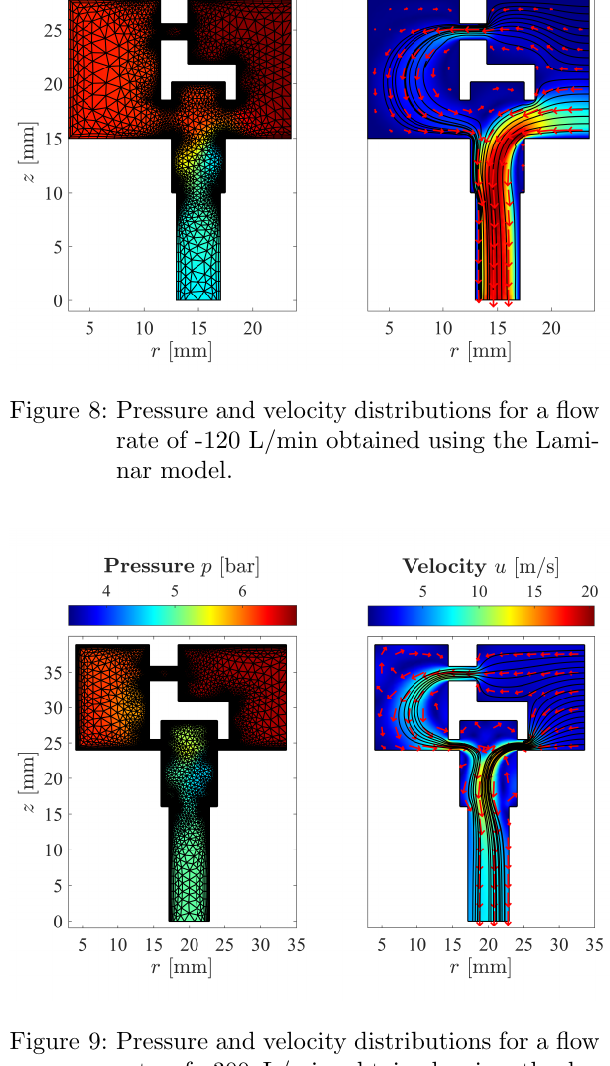
Table 2: Information for the results in Fig. 8 and 9. [ L stroke ,R seat ,W seat